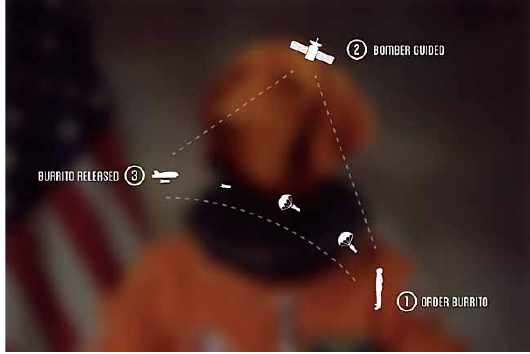
Fig. 4. Principle scheme of the “Burrito bomber“ (Source: